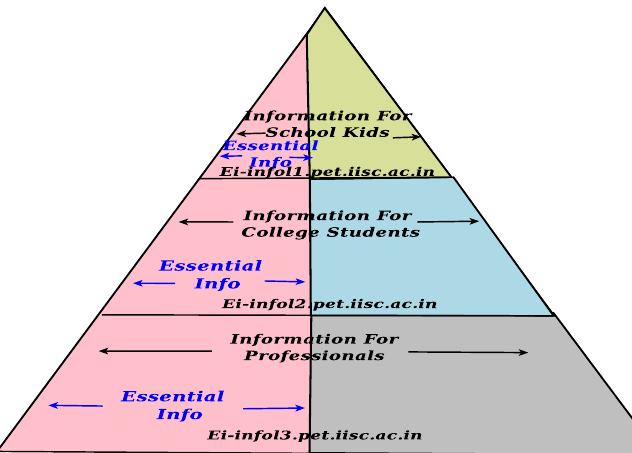
Figure 1. Organization Layout of Museum Exhibit